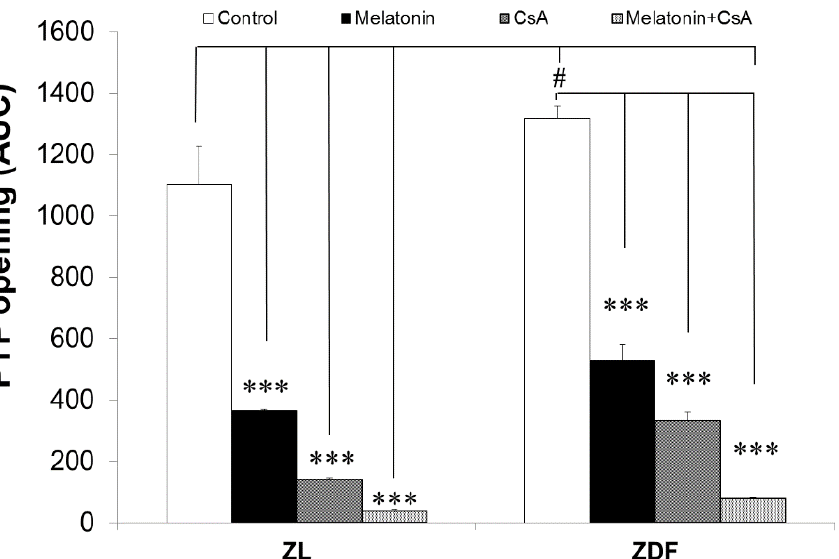
Figure 7. The effect of melatonin treatment on calcium-induced permeability transition pore (PTP) in mitochondria isolated from BAT of control (untreated) and melatonin-treated ZDF and ZL rats. The effect of cyclosporine A (CsA) was included as a classical inhibitor of mitochondrial PTP. Data are shown as mean ± SD of the area under the curve (AUC). Superscript letters identify significant difference measured using two-way ANOVA followed by the Tukey post hoc test. ZL, Zücker lean rats; ZDF, Zücker diabetic fatty rats. *** p < 0.001 and # p < 0.05.